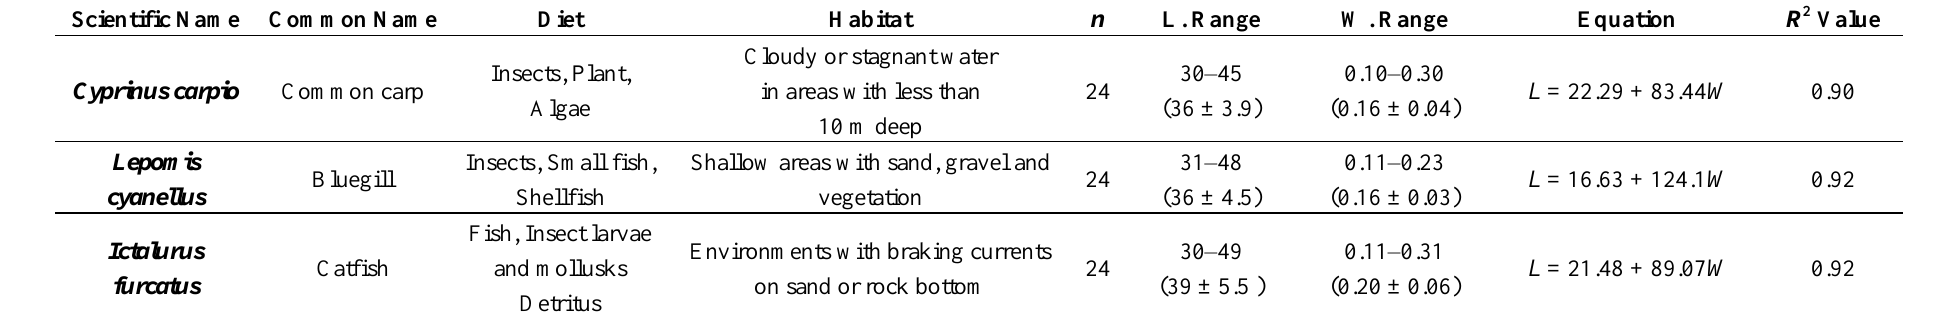
Table 2. General information and relationships between weight in kg (W) and total length in cm (L) of the fish species caught from the Luis L. Leon reservoir [63].